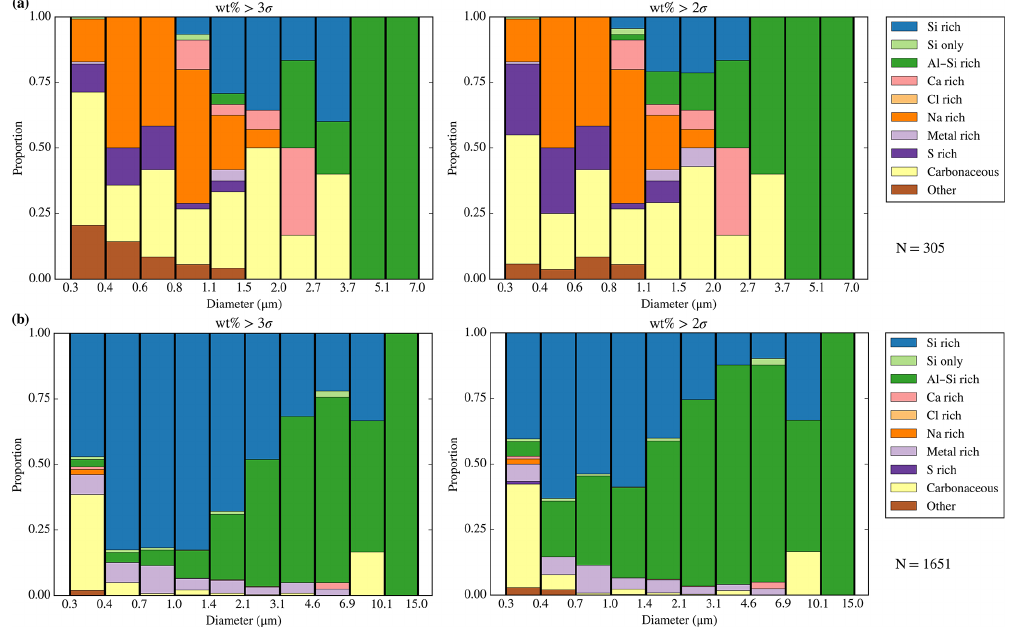
Figure C1. Size-segregated composition of two aerosol samples for different element detection confidence levels. The samples are 18 March 2018 from 19:28 to 19:48UTC in northern Alaska (a) and 2 October 2017 from 16:24 to 16:40UTC in Iceland (b) . The two samples are very different since the first sample presented a very low aerosol loading and it is dominated by Na-rich particles and carbona- ceous and mineral-origin aerosol (Si rich, Si only, Al–Si rich) with significant contributions of S-rich particles, whereas the second sample presented a high aerosol loading and it was mainly dominated by mineral-origin aerosol. The difference in the confidence mainly affected the Si- and Al–Si-rich particles as well as the S-rich particles in sample (a) , whereas it only affected the Si- and Al–Si-rich particles in sample (b)